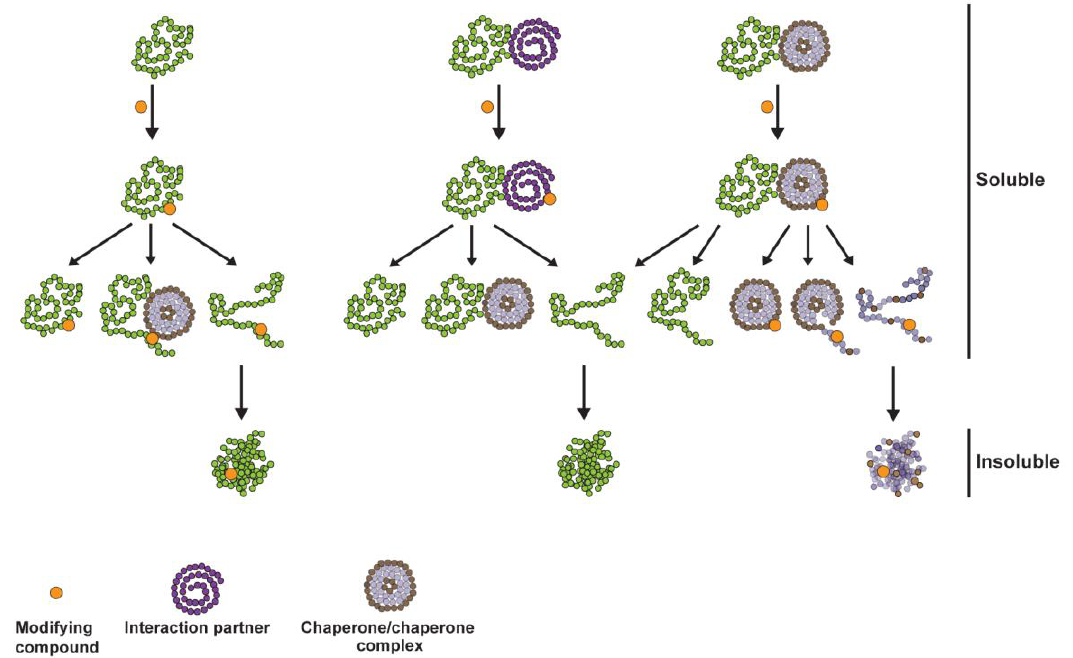
Figure 7. Schematic depiction of events proposed to occur subsequent to compound-induced covalent modification of proteins. Green chains: proteins of interest. Additional proteins that may aggregate include proteins that were to be modified but were not modified as well as proteins that were to be eliminated but were not eliminated because of a failing proteostasis system.